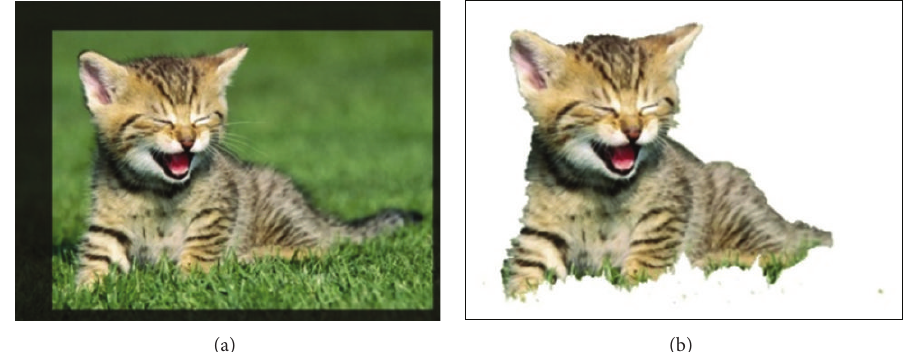
Figure 1: Example of GrabCut segmentation. (a) GrabCut allows the user to drag a rectangle around the object of interest to be segmented. (b) The segmented